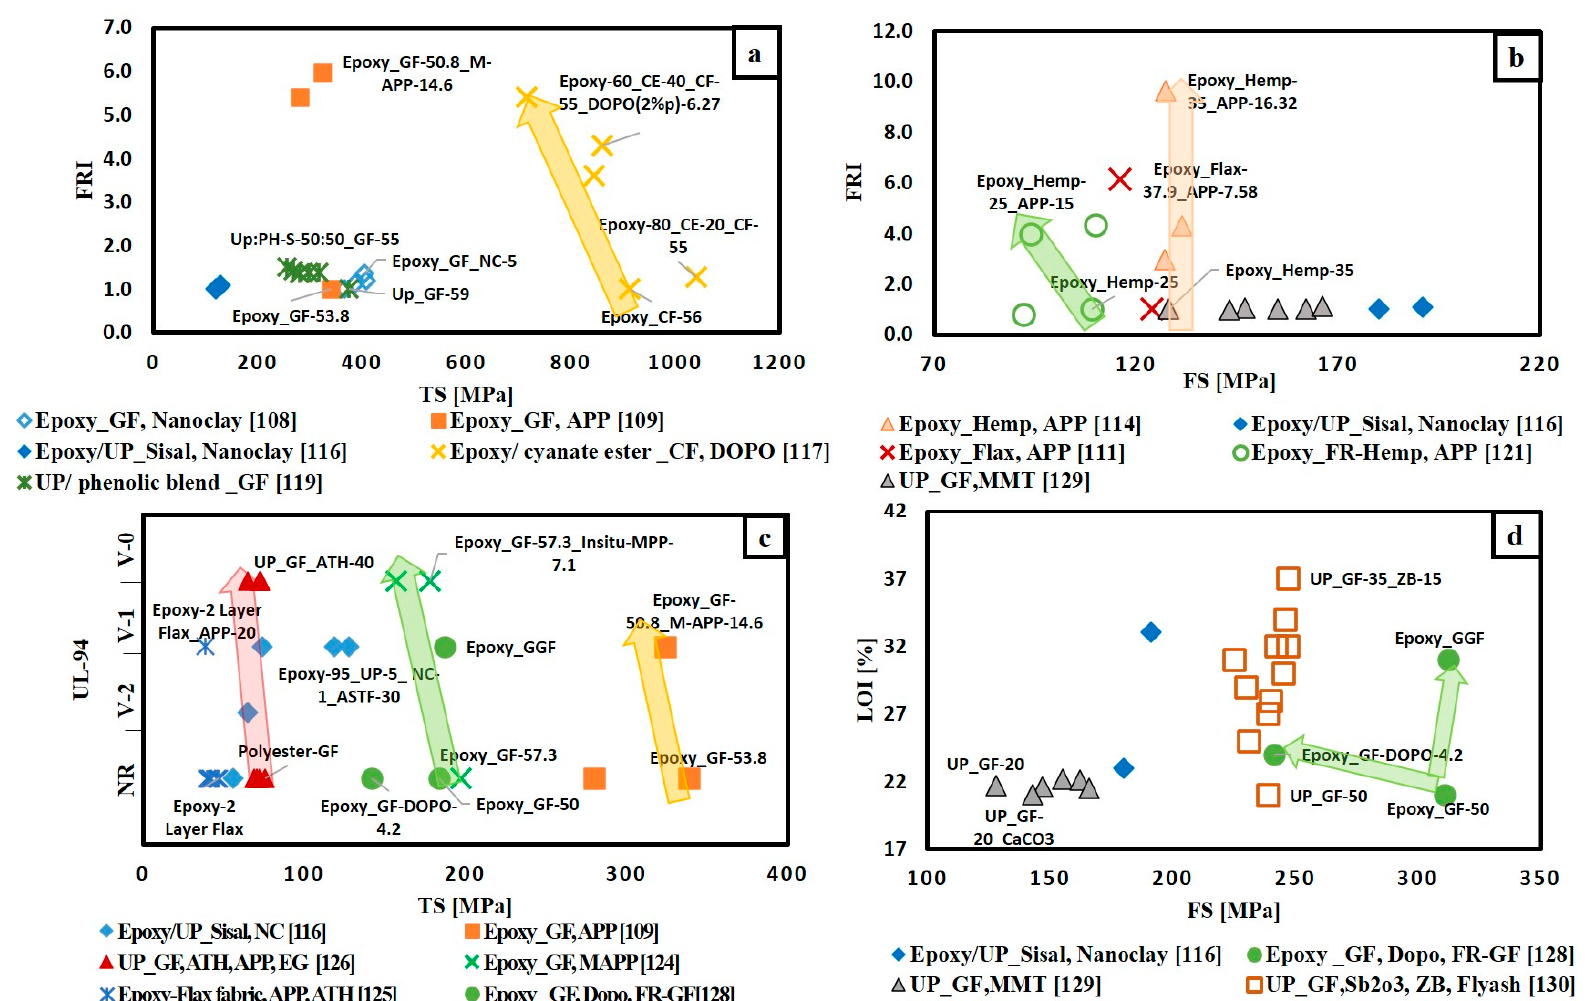
Figure 13. Selection charts of FR type regarding the desired flame retardance level and the mechanical property for epoxy and unsaturated polyester composites ( a ) FRI versus TS; ( b ) FRI versus FS; ( c ) UL-94 versus TS; ( d ) LOI versus